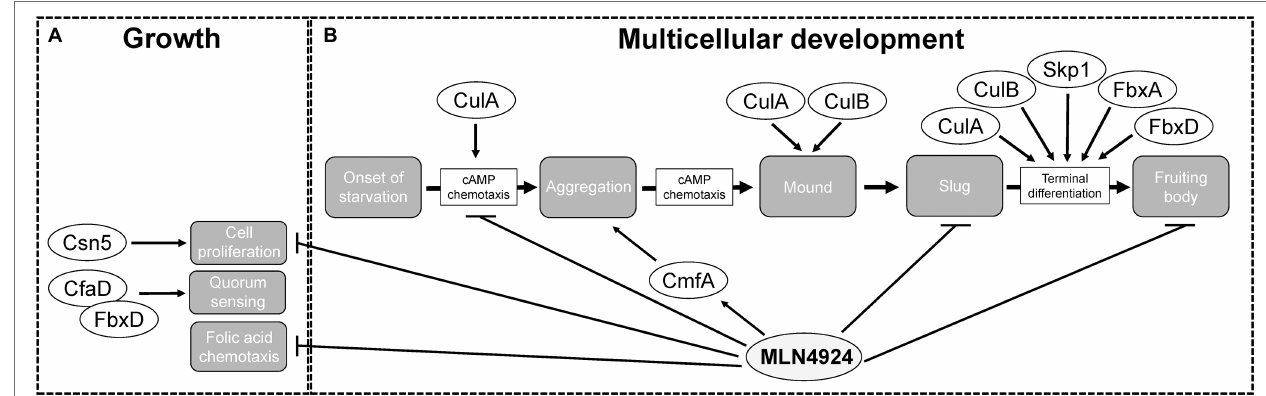
FIGURE 6 | The roles of cullins, neddylation, and the CSN during the Dictyostelium discoideum life cycle. (A) During growth, MLN4924 inhibits cell proliferation and folic acid-mediated chemotaxis. Loss of csn5 also inhibits cell proliferation. FbxD binds CfaD, which plays a role in quorum sensing. (B) During multicellular development, MLN4924 and loss of culA inhibit cAMP-mediated chemotaxis, which delays aggregation. MLN4924 also affects the intracellular and extracellular levels of CmfA, which plays a role in quorum sensing during aggregation. culA − and culB − cells form multi-tipped mounds during development, which is characteristic of D. discoideum mutants with defects in the autophagy pathway. MLN4924 inhibits slug and fruiting body formation. CulA, CulB, Skp1, FbxA, and FbxD collectively regulate fruiting body formation. CfaD, counting factor-associated protein A; CmfA, conditioned media factor A; Csn5 and COP9 signalosome complex subunit 5; Cul, cullin; Fbx, F-box protein; and Skp1, S phase kinase-associated protein 1.